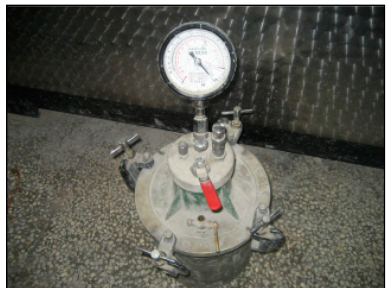
Figure 2. Air-void analyzer of hardened concrete. Figure 1. Air content analyzer of fresh concrete. Figure 1. Air content analyzer of fresh concrete. Figure 1. Air content analyzer of fresh concrete.